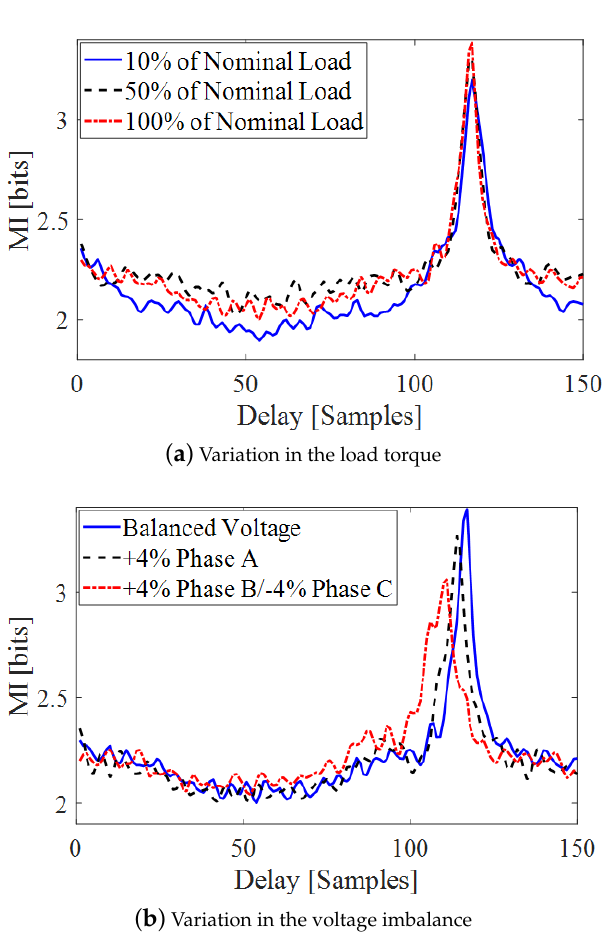
Figure 6. Analyzes of variations in the load torque and voltage imbalance levels—Motor 1 operating with bearing